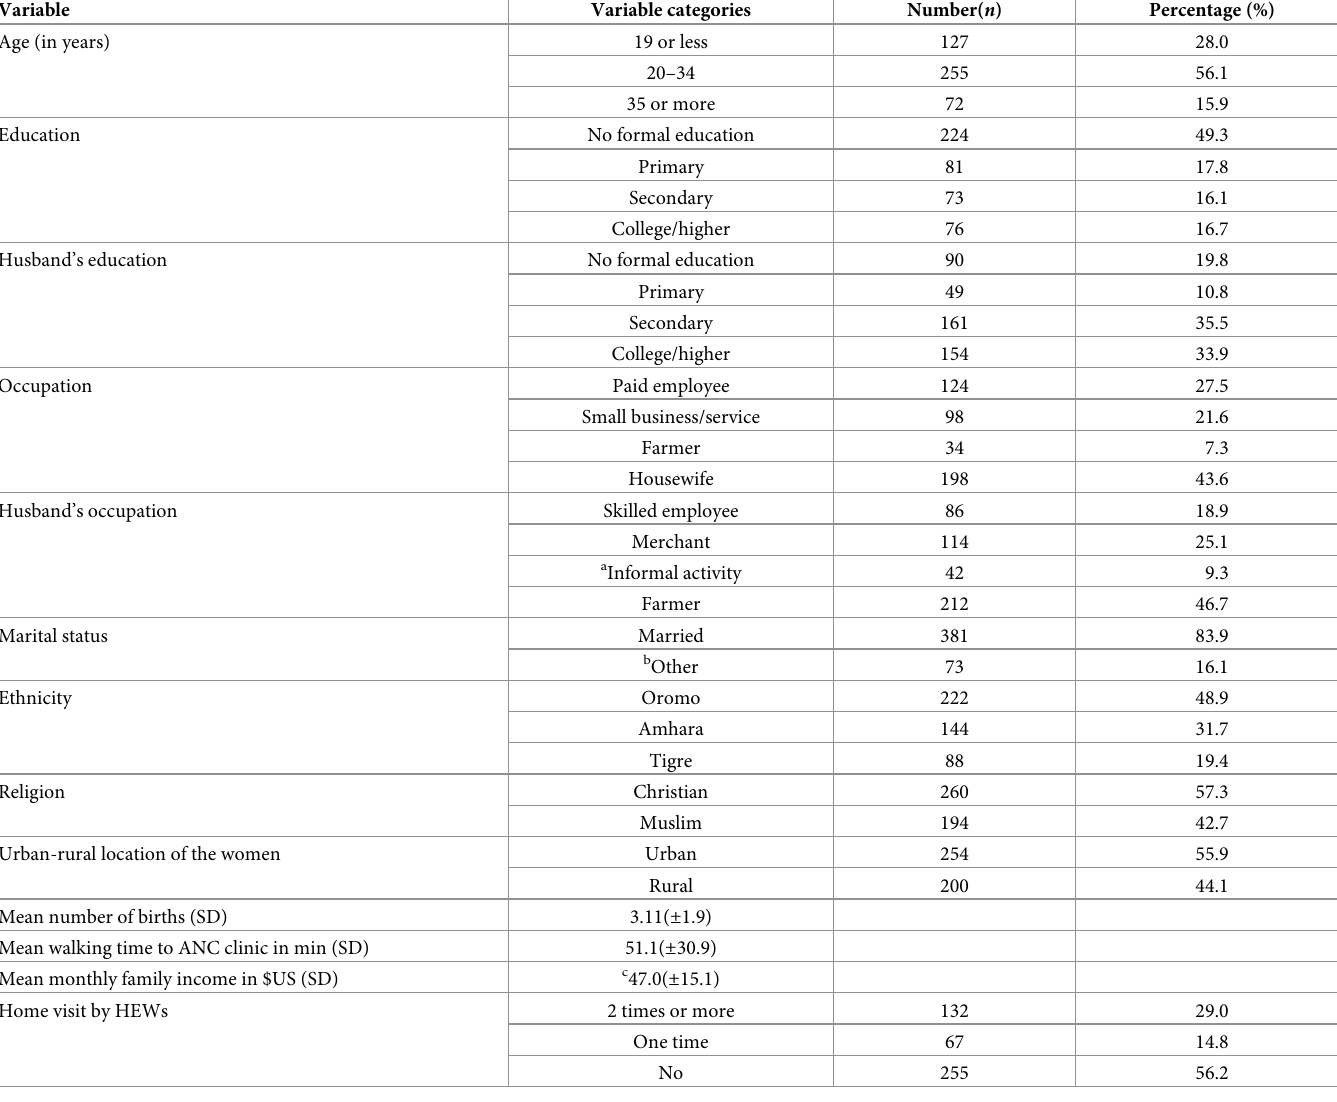
Table 1. Socio-demographic backgrounds of the study participants and home visits, in Gida Ayana Woreda , rural western Ethiopia, during Nov. 2016 to Jan 2017 ( N = 454).